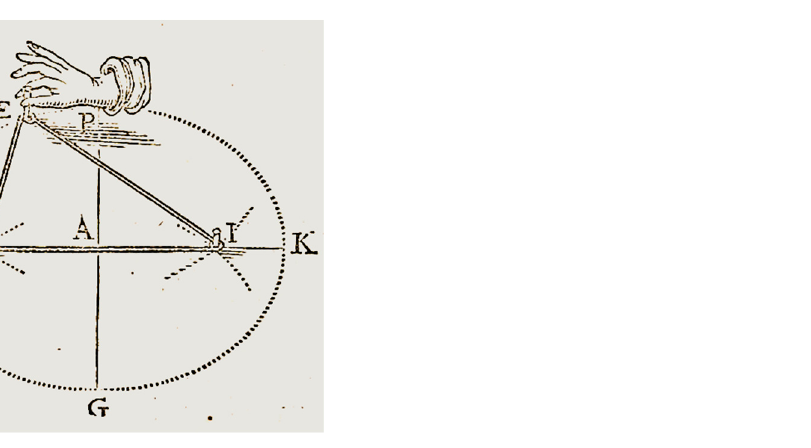
Figure 8. Illustration from Frans van Schooten, De Organica Conicarum Sectionum […], (Van Schooten 1646, p. 31) displaying the creation of an ellipse using a nail and string, also known as The Gardeners Method.